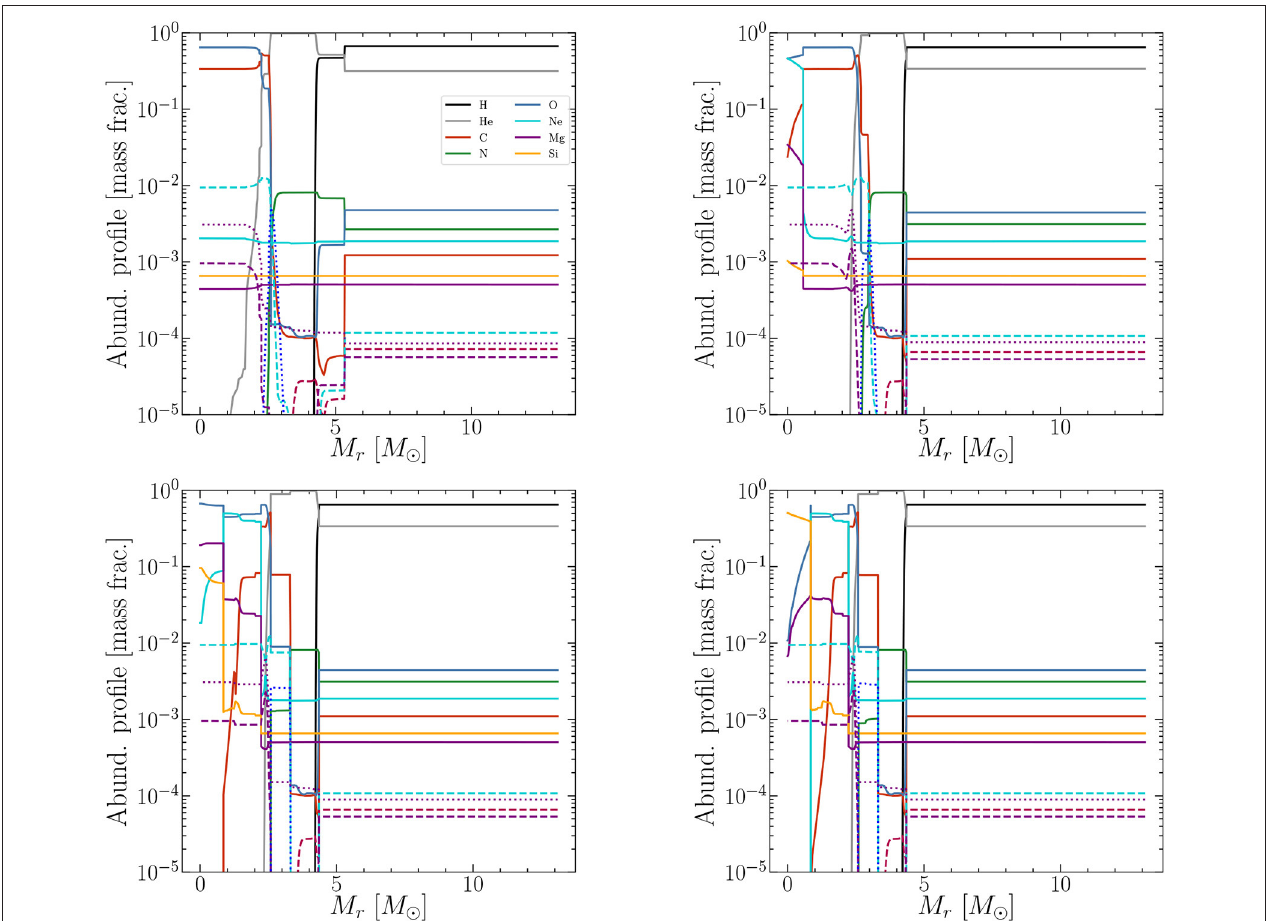
FIGURE 2 | Abundances profiles at the end of He burning ( top left ), C burning ( top right ), Ne burning ( bottom left ), and O burning ( bottom right ). The precise temporal locations are marked by gray arrows in Figure 3 . The species shown are indicated with their colors in the legend on the top left panel. Solid lines are used for the main isotopes ( 1 H, 4 He, 12 C, 14 N, 16 O, 20 Ne, 24 Mg, and 28 Si). For some species, other isotopes are shown with the corresponding colors but dashed ( 13 C, 15 N, 17 O, 22 Ne, and 25 Mg) or dotted lines ( 18 O and 26